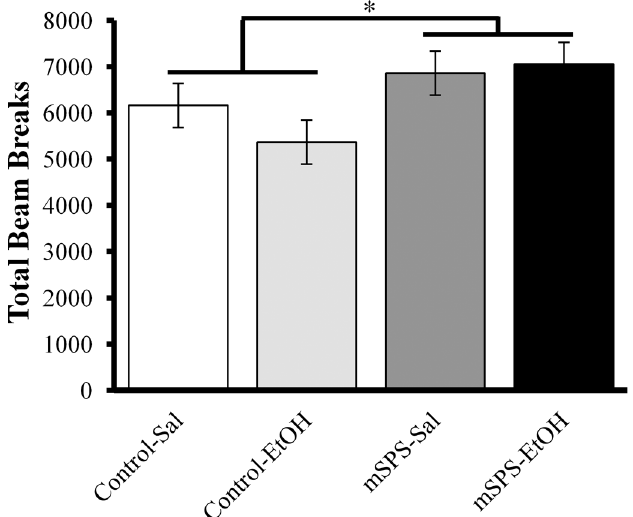
Fig 2. Activity was significantly increased during habituation in mSPS-exposed mice compared to control mice prior to EtOH exposure ( * p < 0.05). doi:10.1371/journal.pone.0155759.g002 6.286, p = 0.015 (Fig 2). Because the mSPS and control groups were significantly different prior